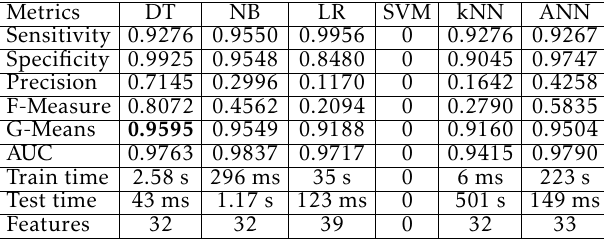
Table 9. Results of using CA-BFE algorithm on SHELLCODE. Metrics